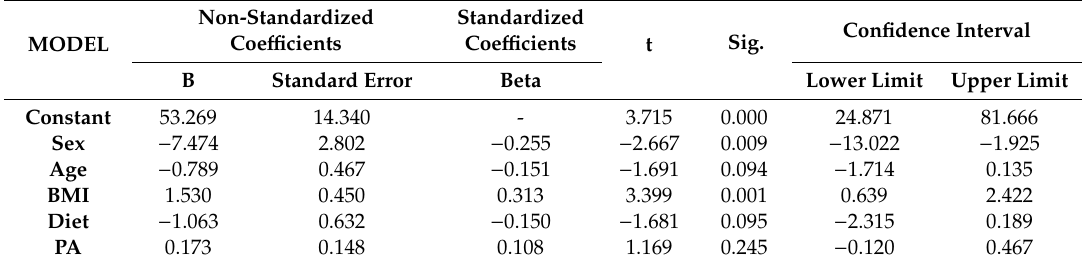
Table 6. Regression analysis on stress and related